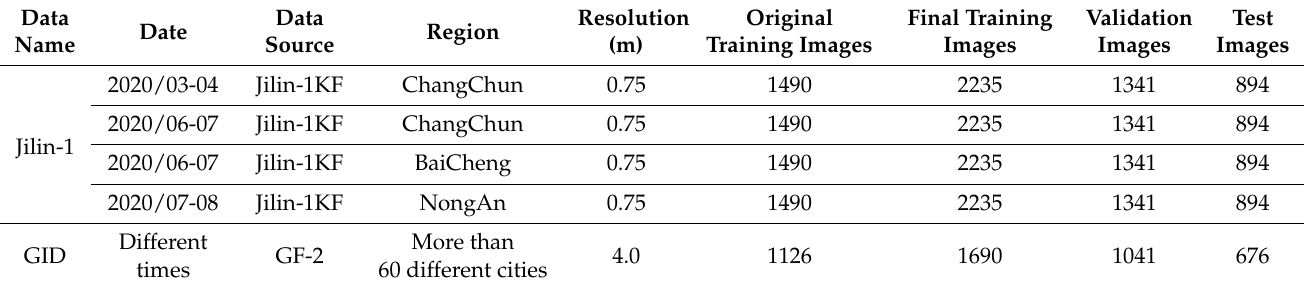
Table 1. Introduction of cropland dataset based on high-resolution remote sensing images for this